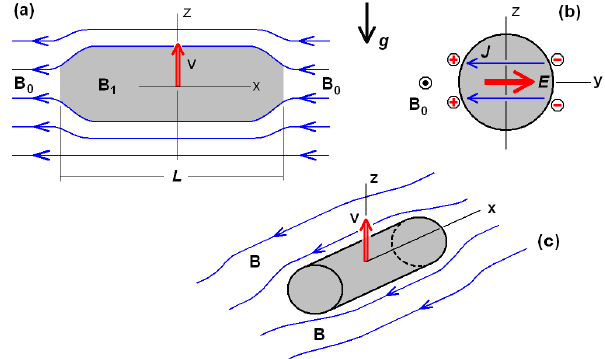
Fig. 9. Motion of a plasma roll extended along the ambient magnetic field B 0 shown by blue lines. B 1 is the magnetic field within this roll, L is its length, g is the effective gravitational acceleration, and V is the E × B drift velocity. The ambient magnetic field is assumed to decrease along the z-axis, which is normal to the reconnection layer (not shown). The hot plasma roll is expelled toward the weaker magnetic field (along the z-axis) due to the effective buoyancy force and moves upward at the velocity V . (a) shows the motion of the roll in the x-z plane. (b) shows the drift currents J (blue lines) and polarization electric field E in the cross-section of the magnetic role; the ambient magnetic field B 0 here is directed across the figure plane. (c) shows motion of the roll in 3-D space; the roll moves upward in between the ambient magnetic field